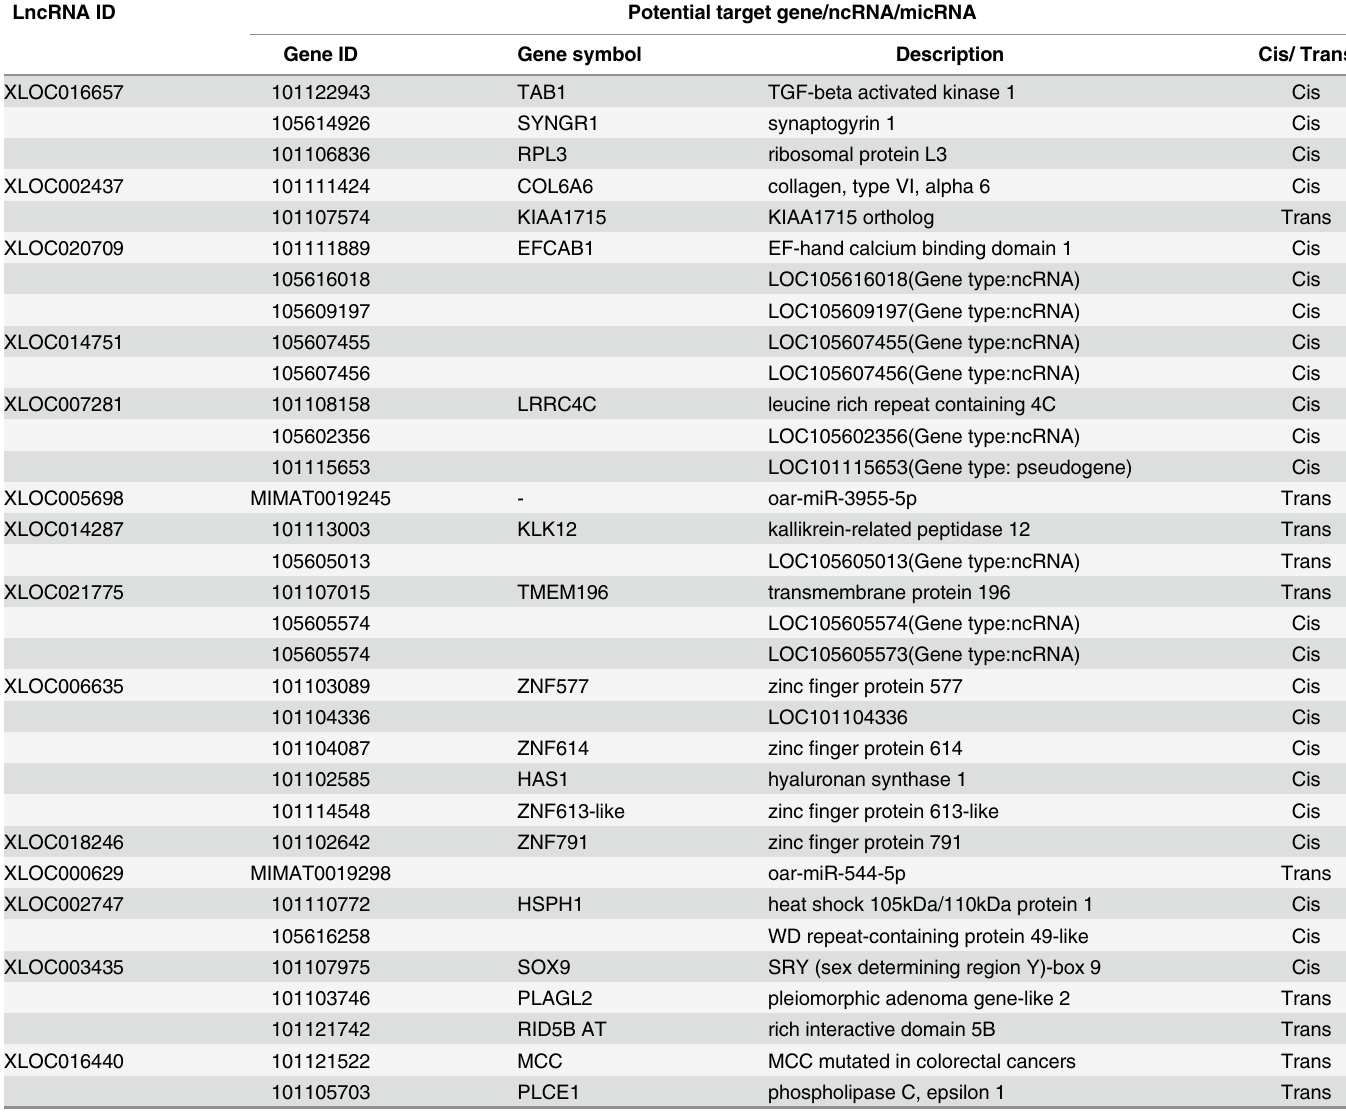
Table 3. Potential cis or trans target gene,ncRNA,micRNA of differentially expressed LncRNA. LncRNA